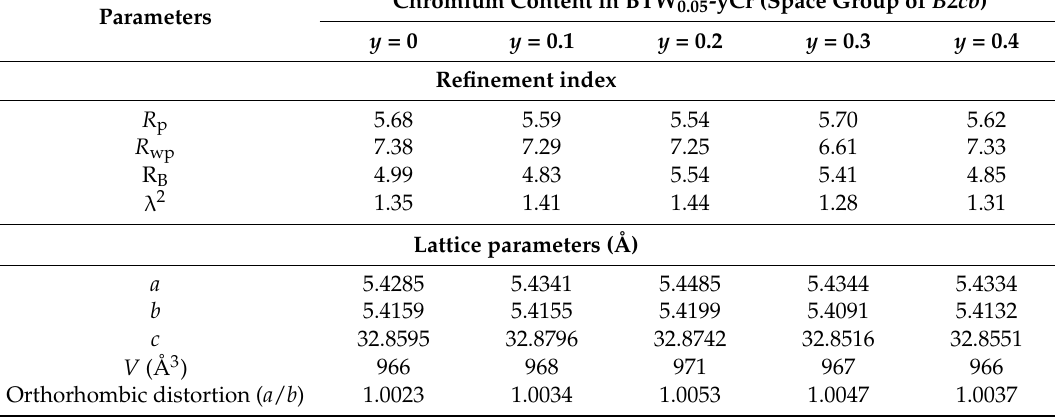
Table 3. Rietveld refinements for the crystal structure of BTW 0.05 -yCr at 295 K.